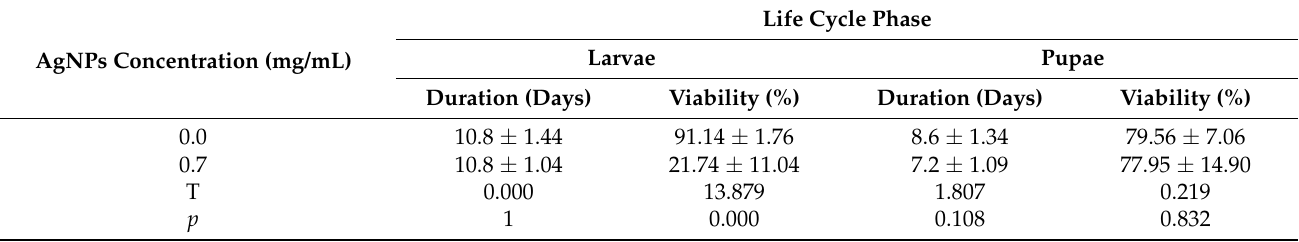
Table 4. Analysis of the impact of silver nanoparticles synthesized with the fungus Isaria fumosorosea (LC 50 ) on the development of Plutella xylostella